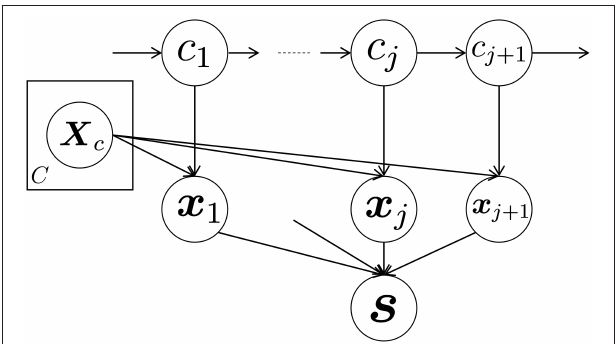
FIGURE 3 | Graphical representation of the proposed GP-HSMM.